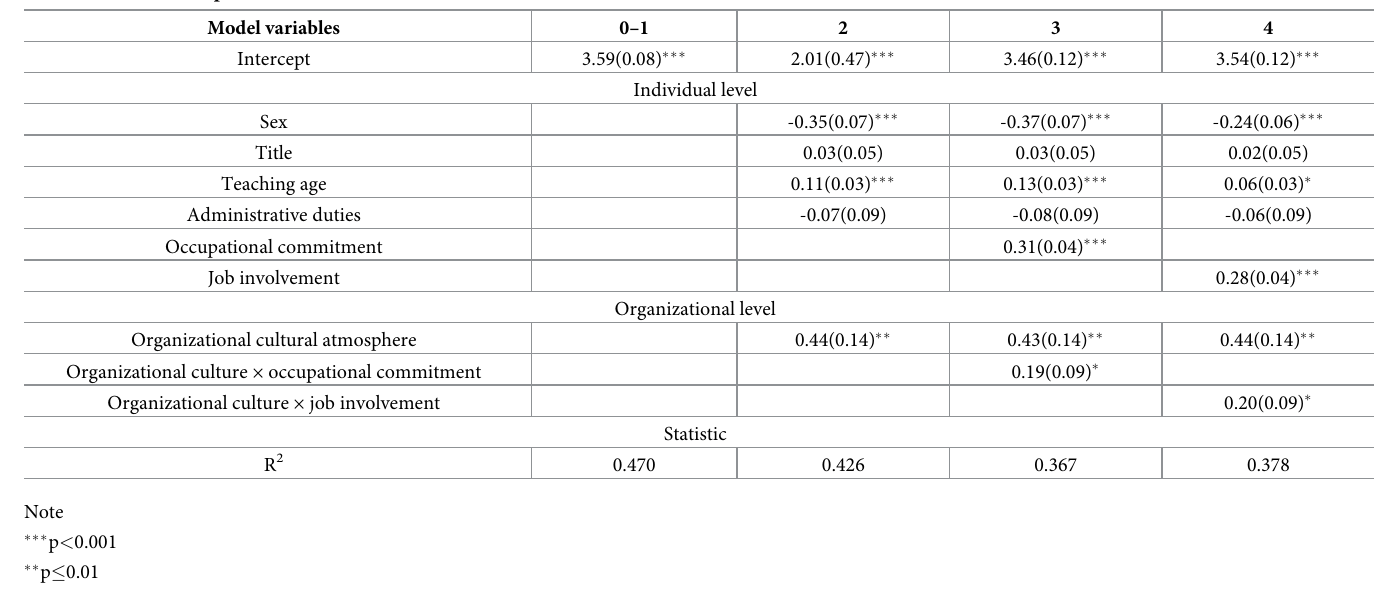
Table 7. Effects on cooperative